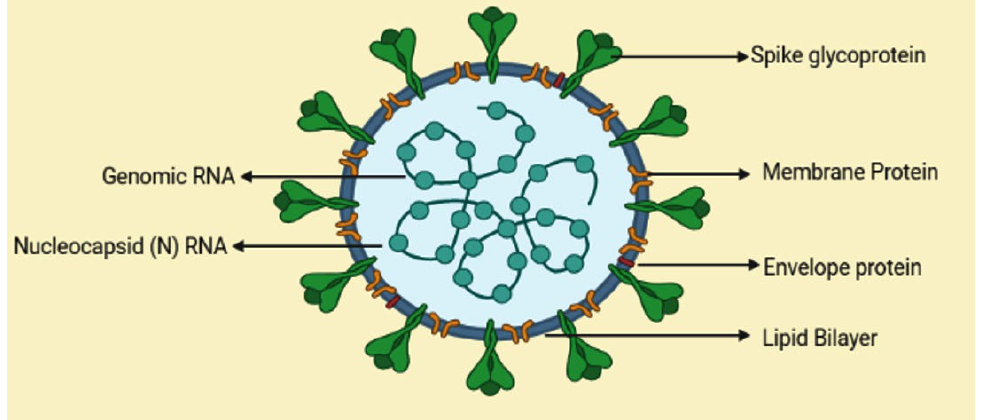
Fig. 1. Structural characteristic of novel coronavirus showing, Nucleocapsid (N) protein is associated to the single- stranded genomic RNA (ssRNA), that is covered with the aid of using an outer envelope of the primary structural proteins: S glycoprotein (S), membrane protein (M) and envelope protein